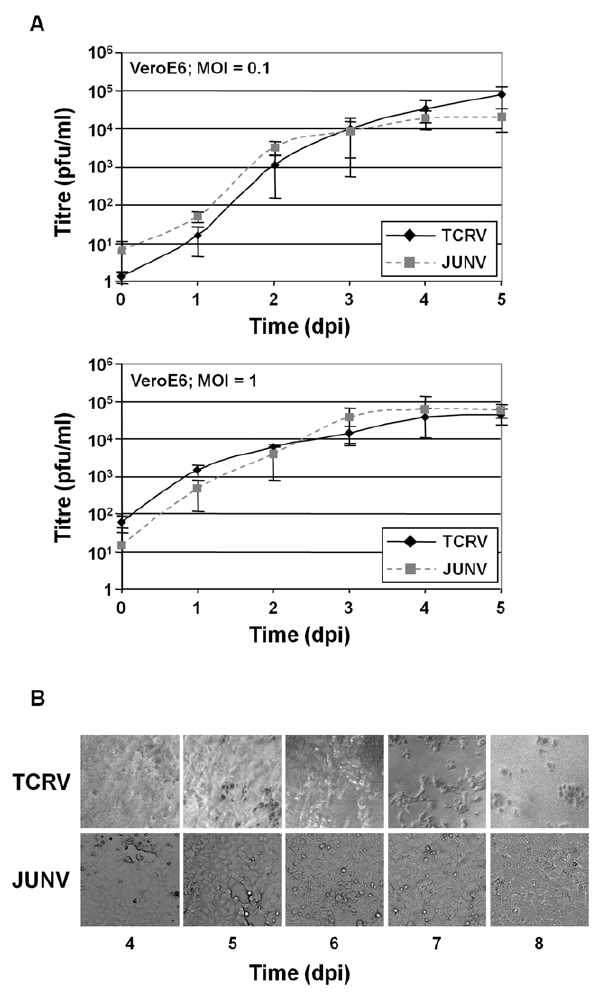
Figure 1. Comparison of virus growth and CPE formation during TCRV and JUNV infection of VeroE6 cells. (A) Virus growth during TCRV and JUNV infection. Sub-confluent VeroE6 cells were infected in a 6 well format with either TCRV or JUNV at an MOI of either 0.1 (upper panel) or 1 (lower panel). Cell culture supernatants were harvest immediately after infection and every 24 h thereafter for a period of 5 days. Virus titres in these supernatants were determined by plaque assay (B) CPE formation during TCRV and JUNV infection. VeroE6 cells were infected as described for (A) and CPE formation was monitored. Data are shown starting from the time of onset of CPE formation.